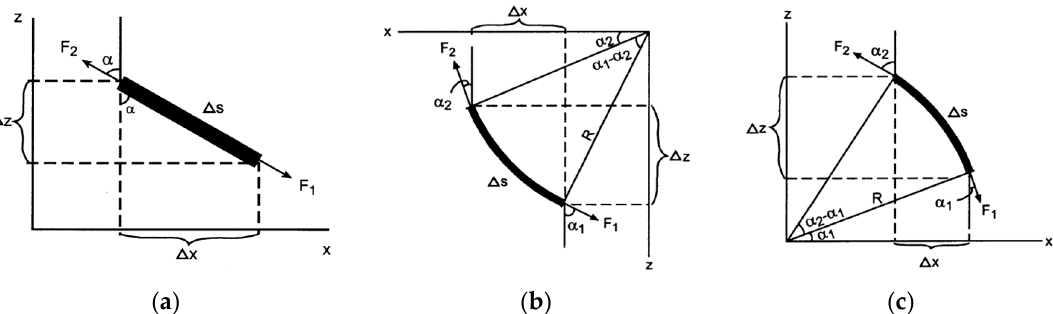
Figure 3. Forces and geometries of various hole profiles [53]. ( a ) Straight inclined section; ( b ) Built ‐ up section; ( c ) Drop ‐ off section.